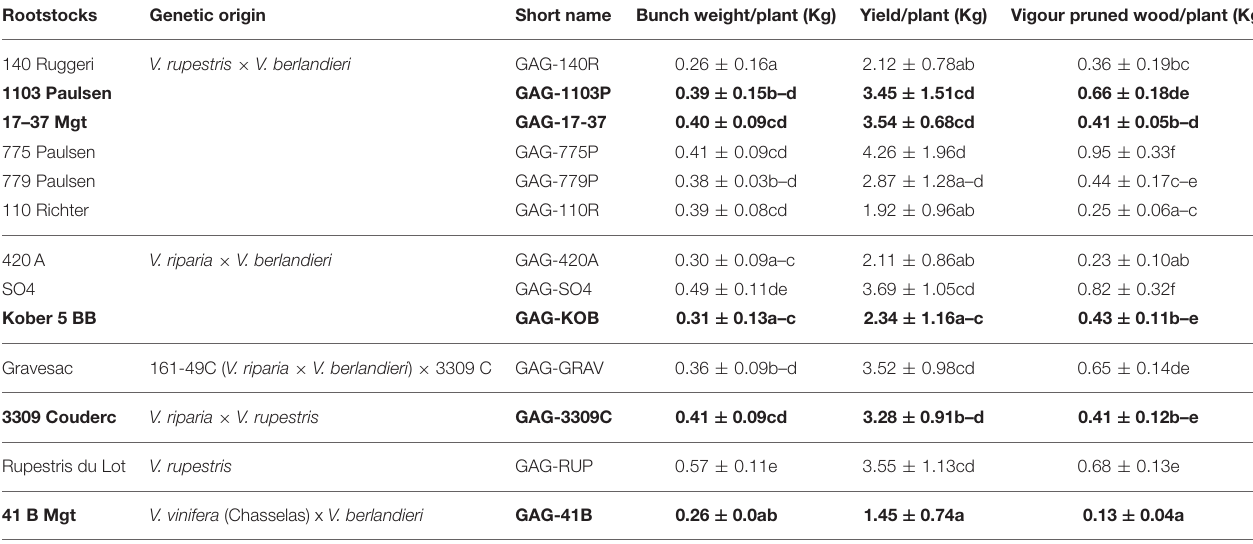
TABLE 1 | Description of the graft combinations analyzed. Rootstocks Genetic